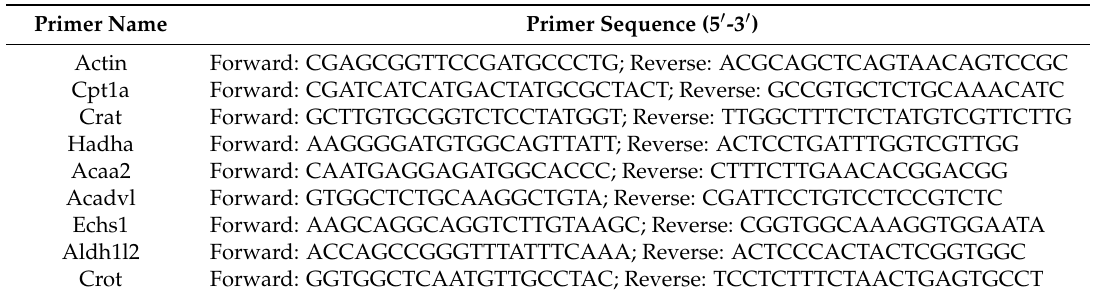
Table 1. Real-time polymerase chain reaction (PCR) primers used in this